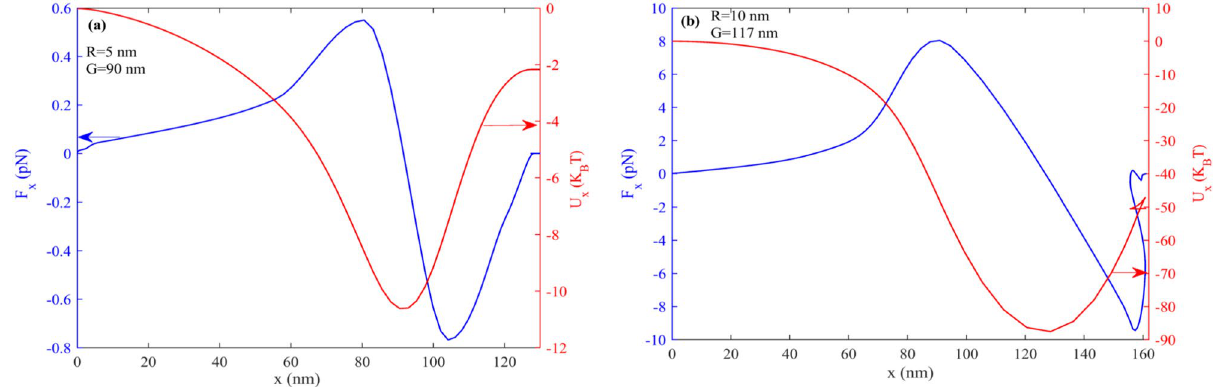
Figure 12. Force and potential of trapping versus x for nanoparticles ( a ) R = 5 nm and G = 90 nm ( b ) R = 10 nm and G =